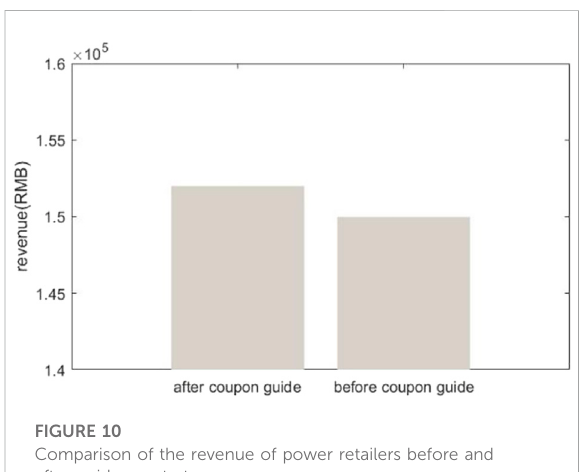
FIGURE 10 Comparison of the revenue of power retailers before and after guidance strategy.